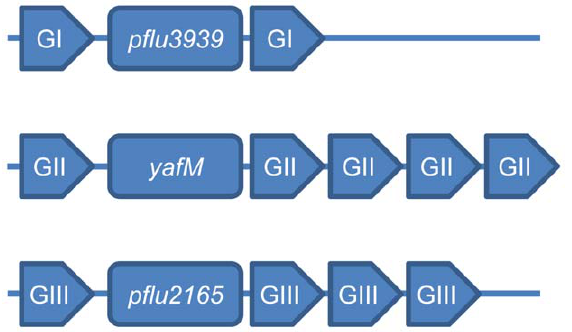
Figure 5. Proximity of GI, GII, and GIII REPIN clusters to RAYT genes in the P.fluorescens SBW25 genome. The RAYT genes in SBW25 are pflu3939 , yafM and pflu2165 .